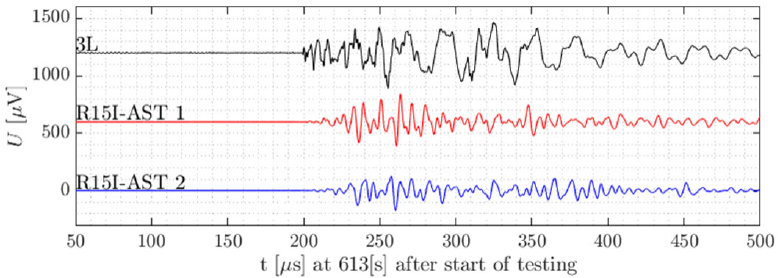
Figure 6. A single AE hit as measured by the embedded sensor L3 and the two R15I ‐ AST sensors [36].